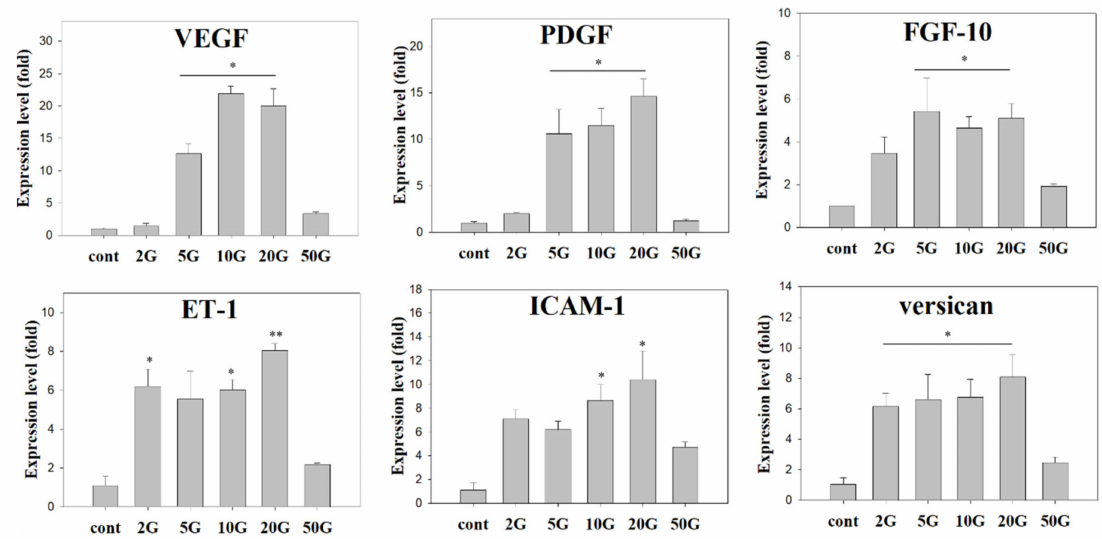
Figure 4. Gene and protein expression levels detected in hair bulb spheroids (HBSs) treated with ELF-EMF. Gene expression of VEGF, PDGF, FGF-10, ET-1, ICAM, and versican measured by qPCR using β -actin as an internal control. Each bar represents the mean ± standard error of independent experiments performed in triplicate ( n = 3). Significant differences were determined via the non- parametric Kruskal–Wallis test; * p < 0.05, ** p <